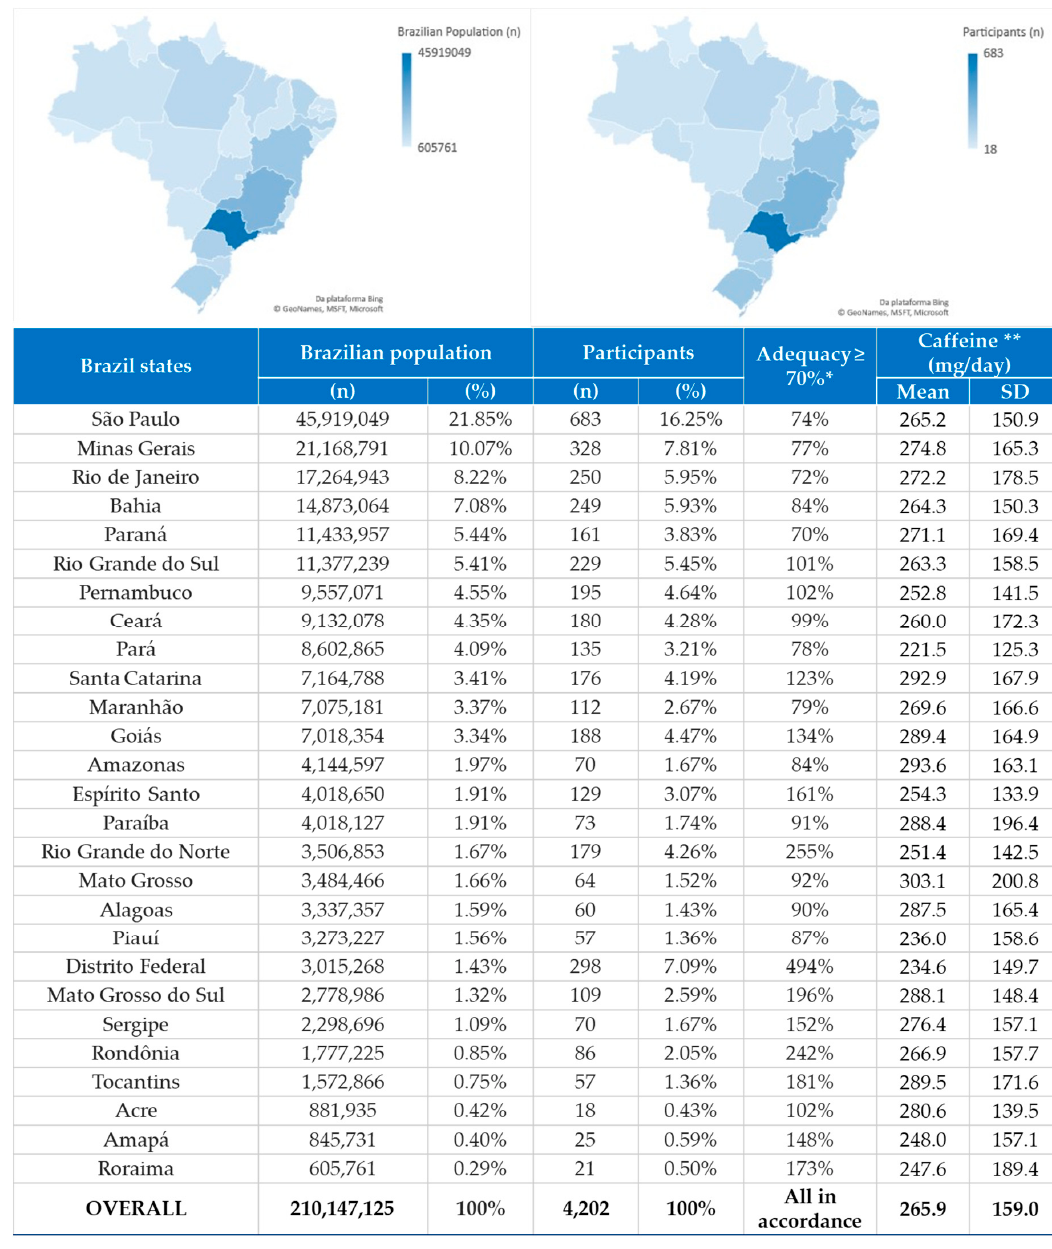
Figure 2. National distribution of participants and average caffeine consumption. * As this is an external validation study of national scope, the sample calculation was performed according to the last Brazilian national census [38], with adequacy greater than or equal to 70% of the sample distribution according to the states of Brazil; ** caffeine in general sources. Northeast Region-Alagoas,